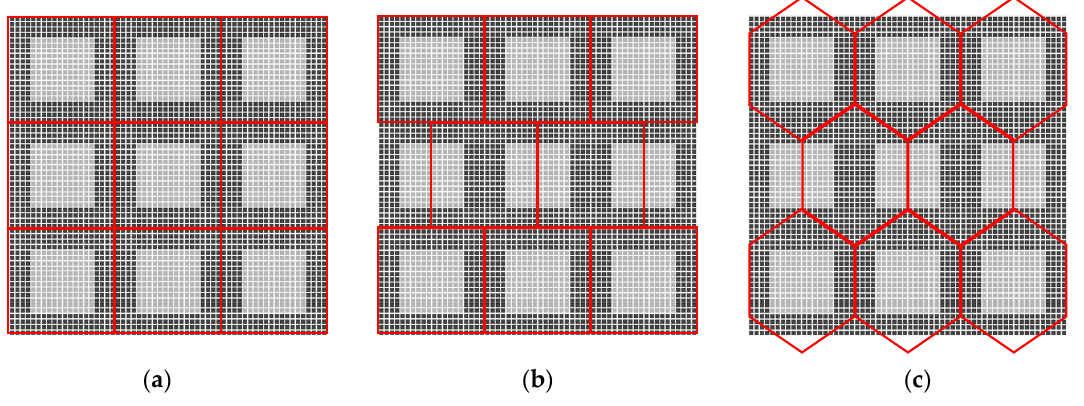
Figure 2. Three types of sensory arrangements. ( a ) The sensor rearrangement onto the subpixel; ( b ) the projection of the square pixels onto the hexagonal arrangement by half-pixel shifting method (i.e., HS_E image generation); ( c ) the projection of the square pixels onto the hexagonal grid in generation of hexagonal image (Hex_E).